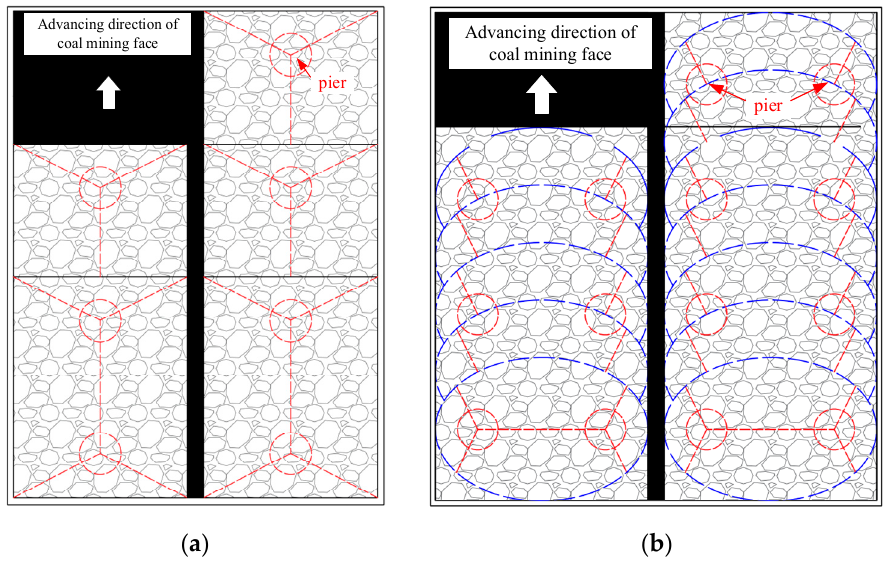
Figure 2. Breakage form of key stratum: ( a ) “Horizontal O-X” break; ( b ) “Vertical O-X” break.